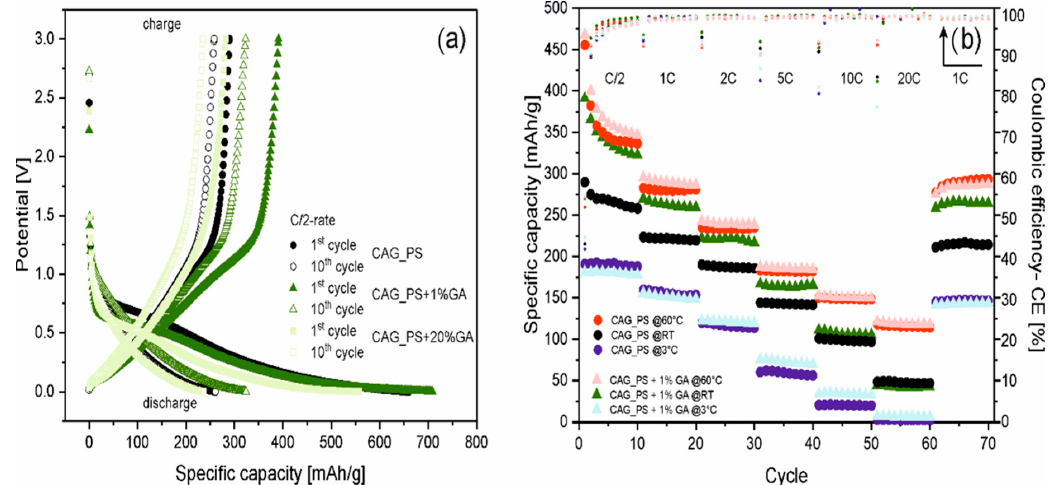
Figure 3. ( a ) Charge–discharge voltage curves for the first and tenth cycles of CAG_PS, CAG_PS+1%GA and CAG_PS+20%GA @RT and @C/2-rate; and ( b ) the galvanostatic charge–discharge tests at various temperatures for the CAG_PS+1%GA and CAG_PS as a reference.